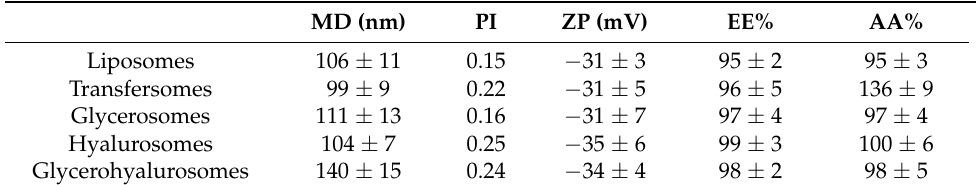
Table 3. Mean diameter (MD), polydispersity index (PI), zeta potential (ZP), entrapment efficiency (EE%) and antioxidant activity (AA%) of T. marum extract loaded in liposomes, transfersomes, glycerosomes, hyalurosomes and glycerohyalurosomes. Mean values ± standard deviations are reported ( n ≥ 6).